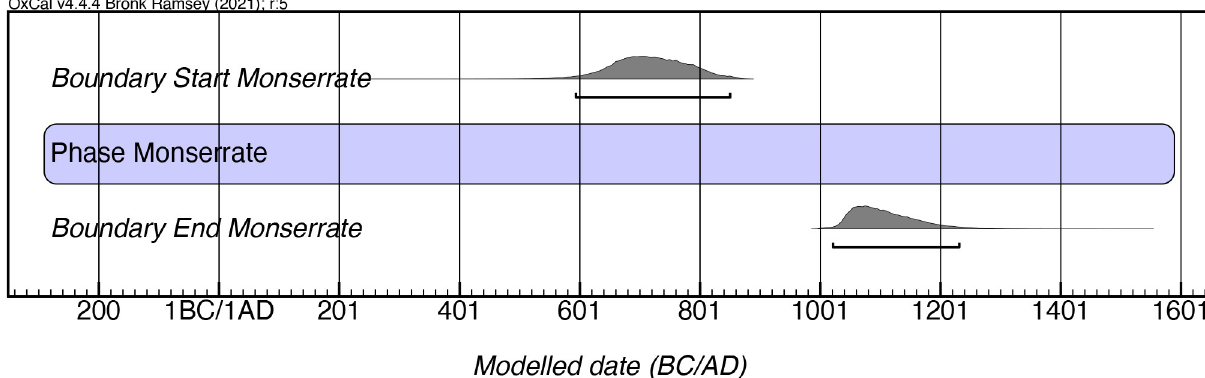
Fig 13. Modeled date ranges for the Monserrate style in Puerto Rico. Probability distributions indicate modeled 2 σ (95.4%) confidence intervals for beginning and end of phase.